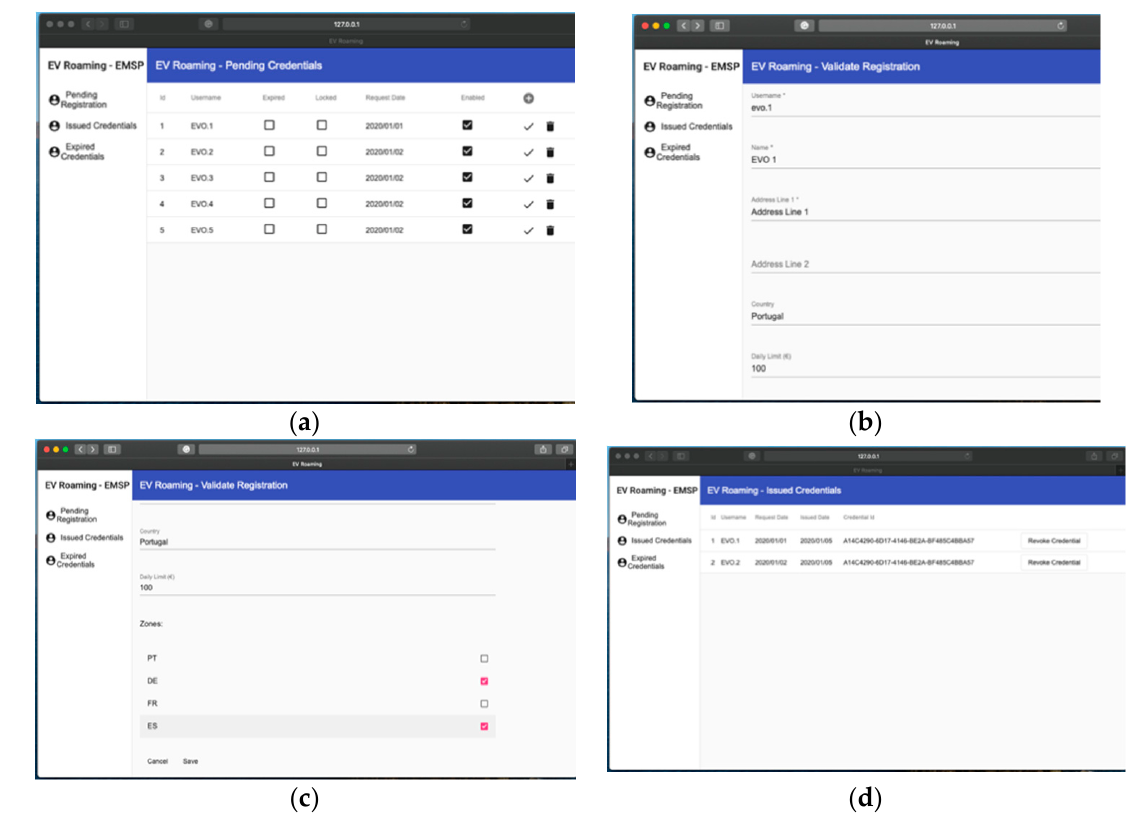
Figure 14. EMSP application screenshots. ( a ) List of pending registration requests; ( b ) Registration request—user details;